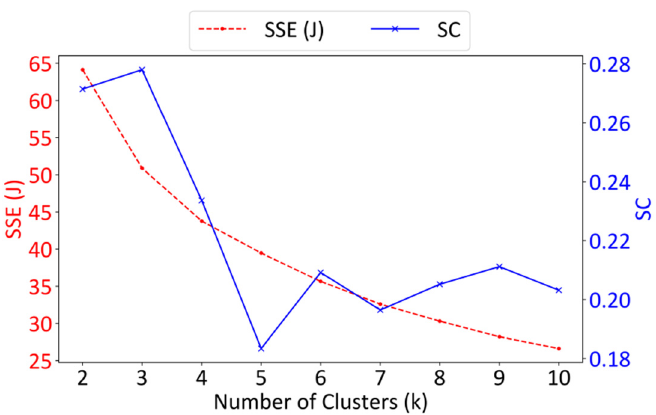
Figure 5. The SSEs and SCs with different values of k .